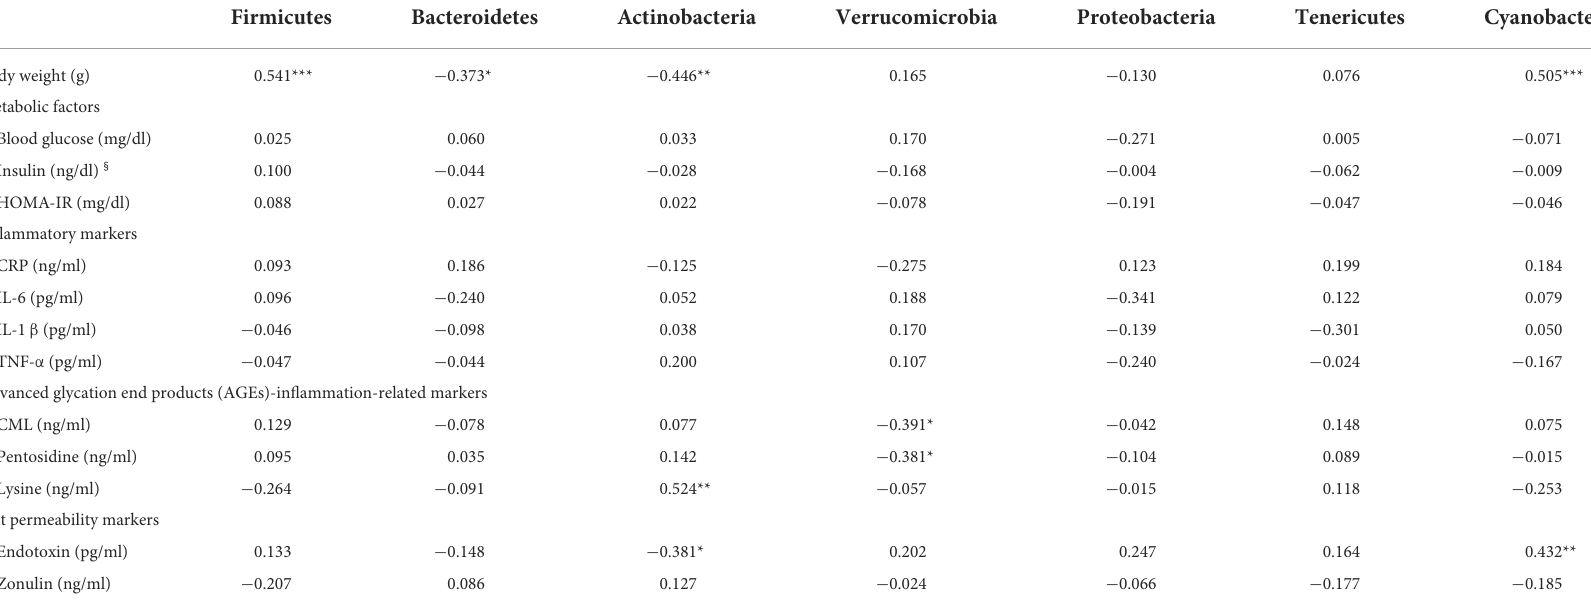
TABLE 4 Spearman’s rank correlation coefficient between gut microbiota composition (phylum level), metabolic factors, and inflammation and gut permeability markers after 12 weeks of